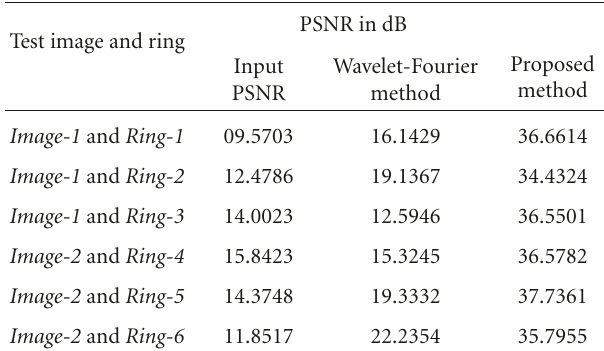
Table 1: Performance comparison of the two methods in terms of